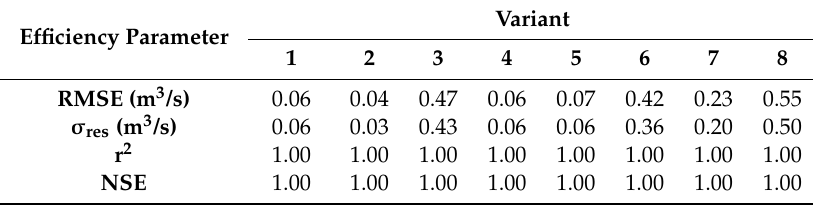
Table 3. Summary of the efficiency parameters for the discharge downstream of the wetland. Variants 1 to 8 are compared with variant 0 (RMSE—root mean square error, σ res —standard deviation of